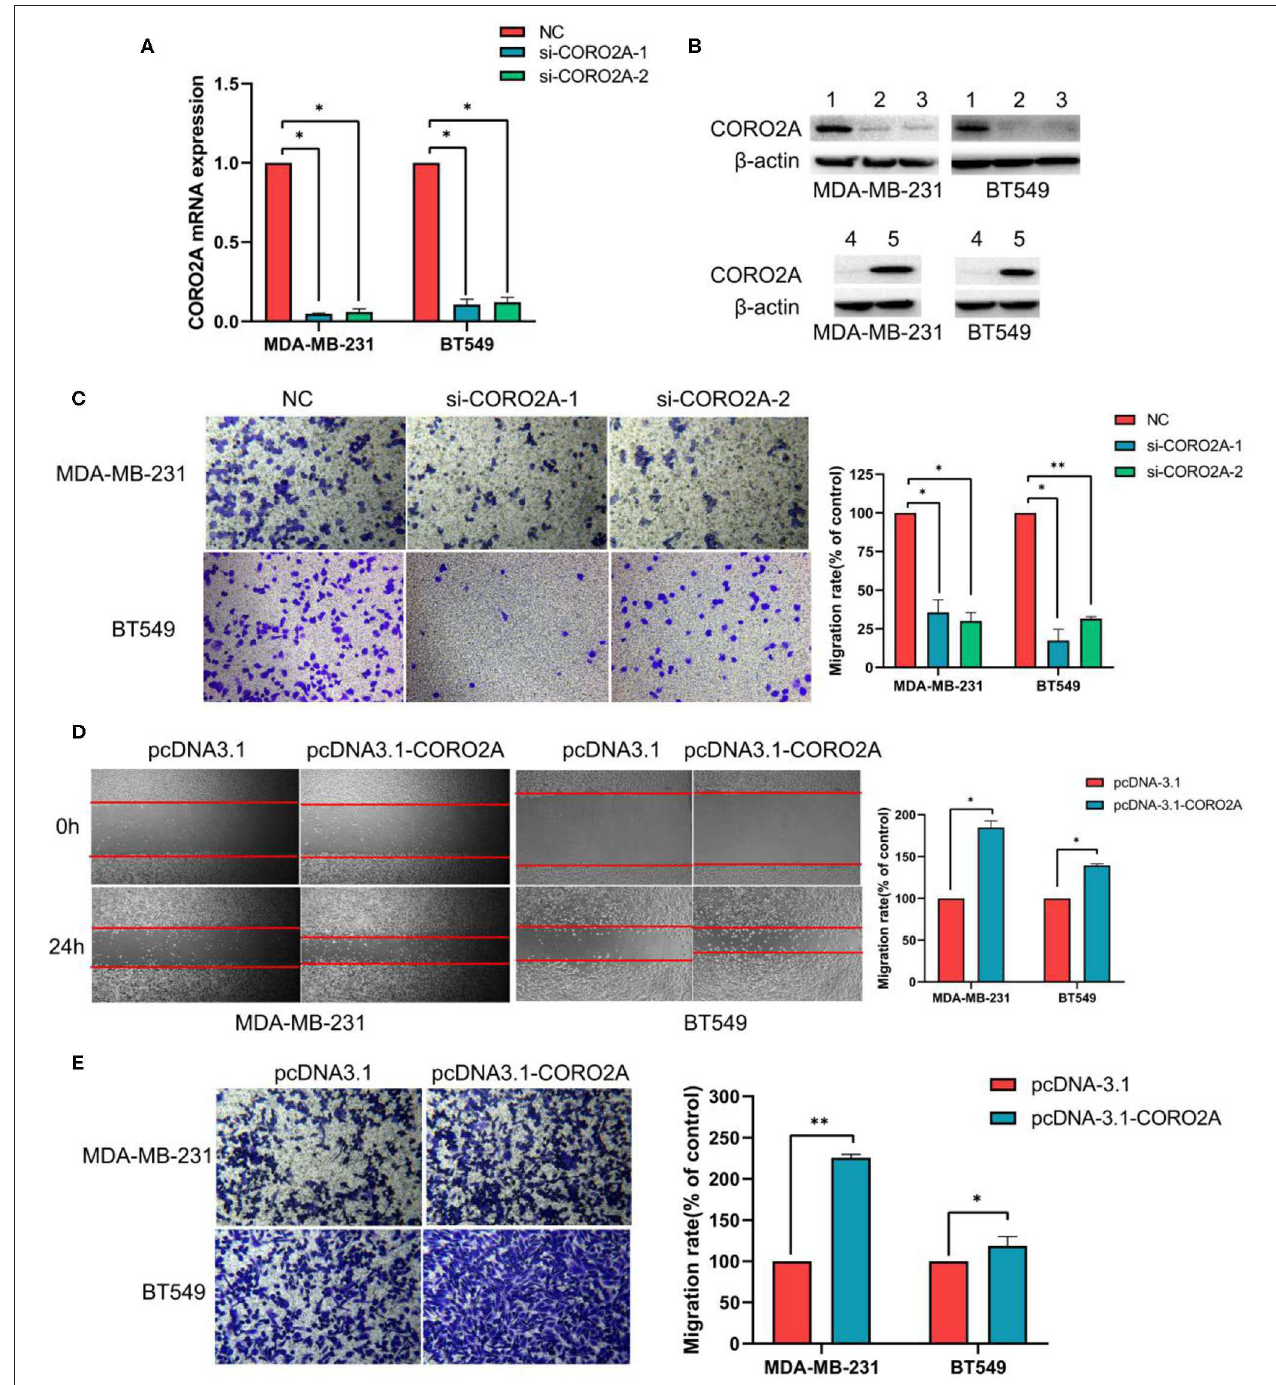
FIGURE 7 | Effect of CORO2A on cell migration in TNBC cell lines. (A) After transfection with CORO2A siRNA for 72 h, the mRNA expression level of CORO2A was assessed by RT-qPCR in MDA-MB-231 and BT549 cells. (B) After transfection with CORO2A siRNA or plasmid for 72h, the protein expression level of CORO2A was assessed by Western blotting in MDA-MB-231 and BT549 cells. Lanes in Western blotting are denoted as: lane 1—NC, lane 2—si-CORO2A-1, lane 3—si-CORO2A-2, lane 4—pcDNA-3.1, and lanes 5—pcDNA-3.1-CORO2A. (C) Representative images of cell migration assays and the mean ± SEM ( n = 3) of three independent experiments of quantitative cell migration assays in MDA-MB-231 and BT549 cells are shown following CORO2A knockdown. Cell migration measured by scratch-wound (D) and Transwell asssay (E) are shown following CORO2A overexpression in MDA-MB-231 and BT549 cells. * P < 0.05, and ** P < 0.01 compared to corresponding negative controls (NC) or